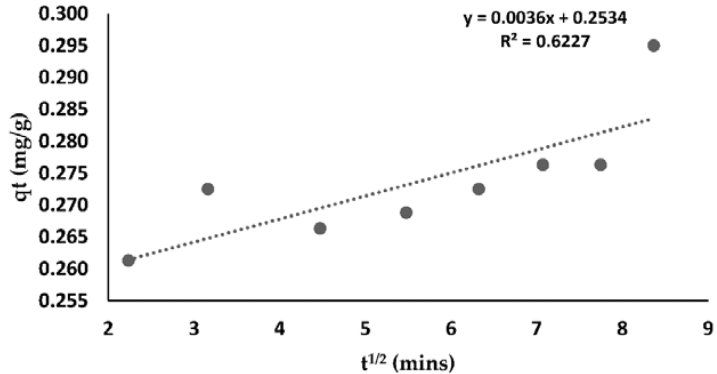
Figure 14. Intraparticle diffusion plot of fluoride on HDTMA-VMT 0.2M .